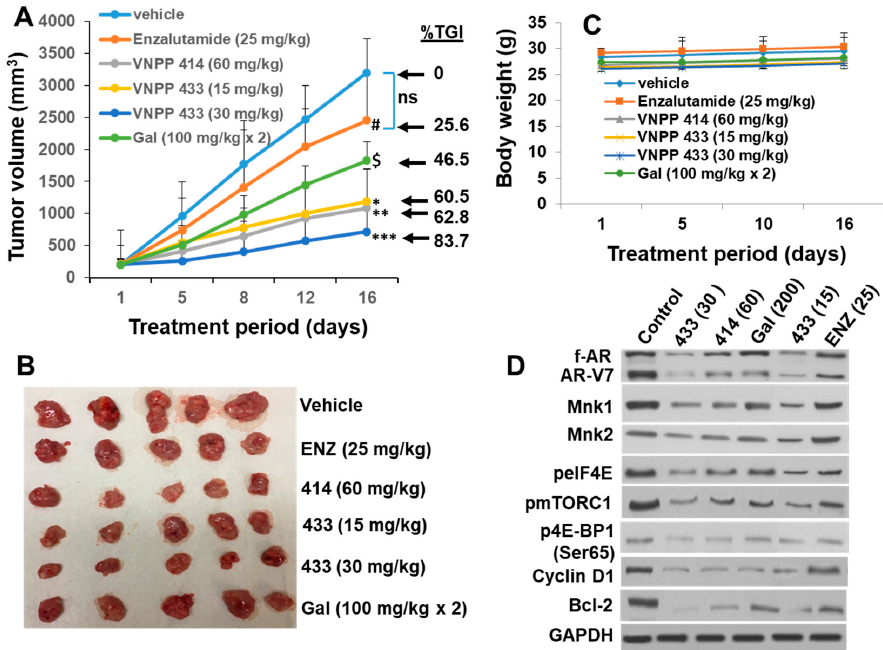
Figure 7. Effects of Gal, NGGAs and ENZ in an in vivo castration-resistant prostate cancer model. ( A ) Mice bearing CWR22Rv1 xenografts (5 mice per group) were treated with vehicle, Gal (100 mg/kg/twice daily), VNPP414 (60 mg/kg, once daily), VNPP433-3 β (15 or 30 mg/kg, once daily) and ENZ (25 mg.kg, once daily) 5 days per week for 16 days. Tumor volumes were measured twice a week and the tumors were collected. Tumor growth inhibition (TGI) values are indicated at the right of each growth curve, and the error bars are the SEM. Results are represented as means ± SEM. # p =